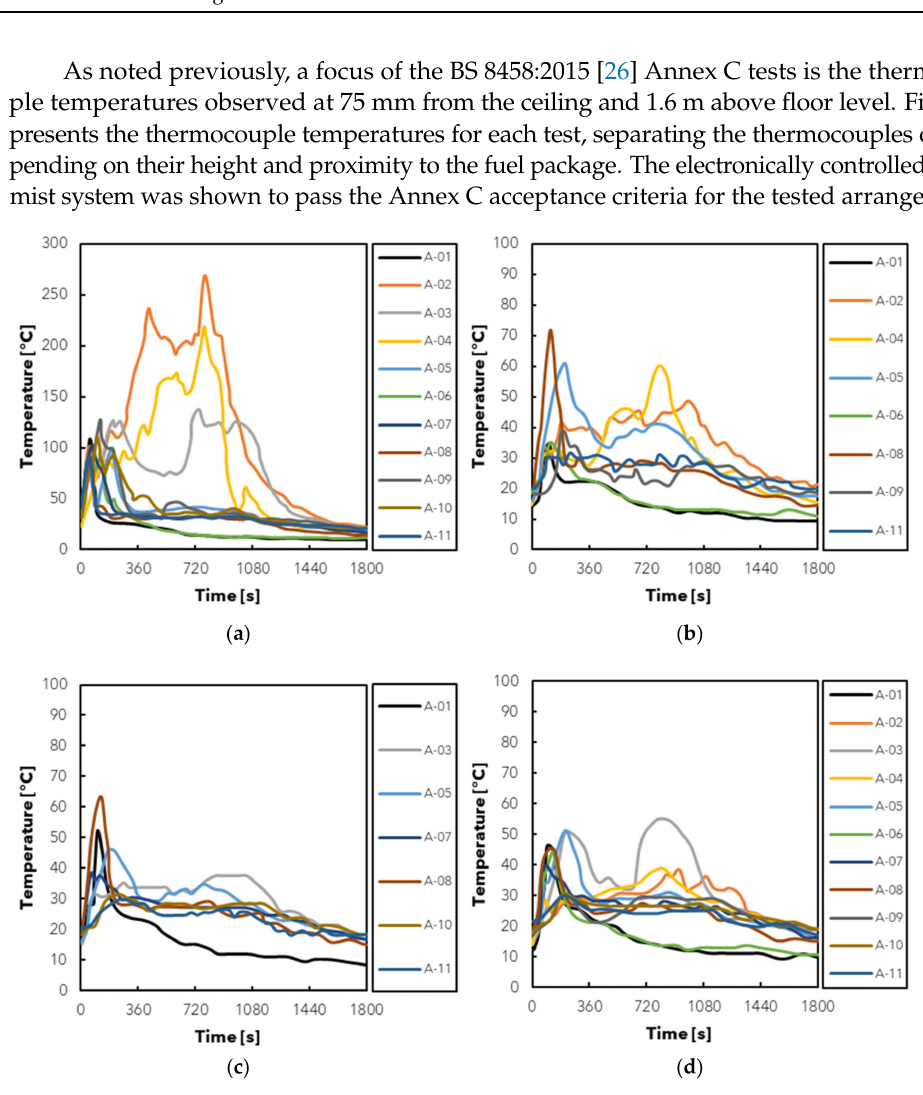
Figure 7. Thermocouple plots for each test: ( a ) 75 mm below ceiling; ( b ) 1.6 m above floor level [closest to fire]; ( c ) 1.6 m above floor level [centre of enclosure]; and ( d ) 1.6 m above floor level [furthest from the